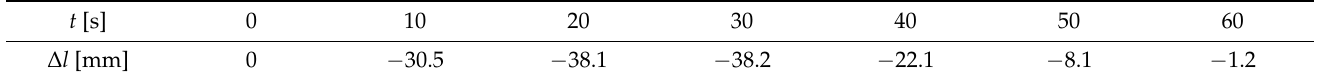
Table 2. Variation in time of the pneumatic muscle axial contraction.